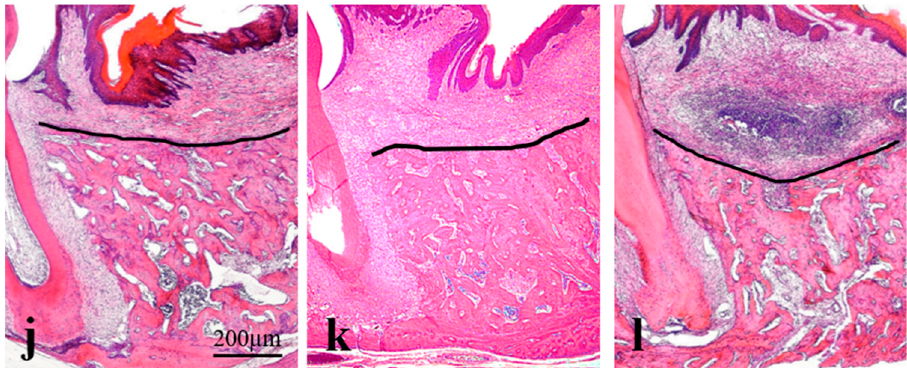
Figure 2. Histopathology on post-extraction days 3, 7, and 21. H&E staining; ( a – c , g – l ) Entire extraction socket, original magnification × 40. ( d – f ) Enlargement of areas indicated by the dotted line in ( a – c ), original magnification × 100. ( a , d , g , j ) CO 2 group. ( b , e , h , k ) Diode group. ( c , f , i , l ) Control group. ( a – f ) Post-extraction day 3. ( g , h ) Post-extraction day 7. ( j – l ) Post-extraction day 21. Arrowheads ( (cid:228) ) indicate osteoclast-like cells. Solid lines indicate bone level. ( a , b ) Progressive organization surrounding the tooth extraction socket, with blood clots observed in only the central area. ( c ) The inside of the tooth extraction socket is almost completely filled with blood clots. ( d ) Many osteoclast-like cells are present in the alveolar bone wall in the extraction socket, showing active bone resorption. ( e ) Near absence of osteoclast-like cells with rapid organization. ( f ) Only a few osteoclast-like cells are present in the alveolar bone wall in the extraction socket. ( g ) Bridging osteoneogenesis extending from the superficial to middle layers of the tooth extraction socket and the bone trabeculae width are favorable, and the structures are more densely packed. ( h )